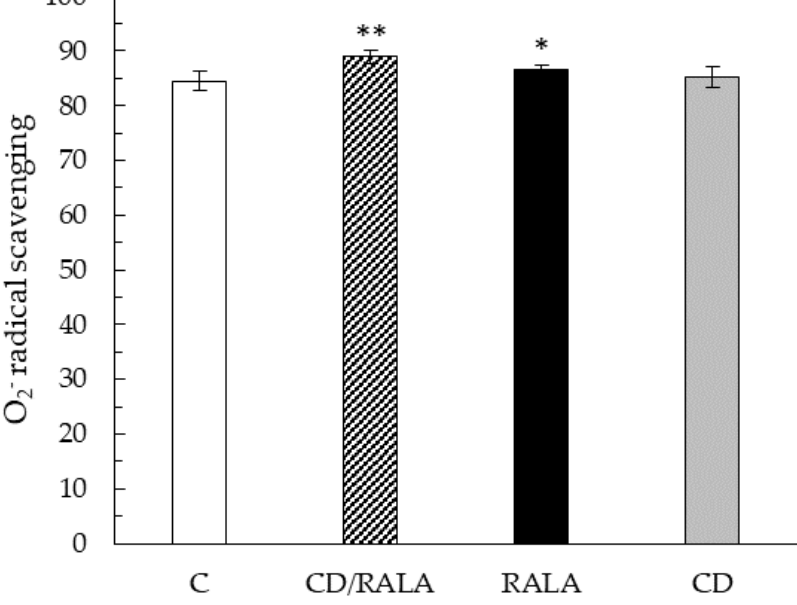
Figure 5. O 2 − radical scavenging activity (%) of the kidney. Values are expressed as the mean ± SD for six mice in each group. C, control group; CD/RALA, R- α -lipoic acid γ -cyclodextrin complex group; RALA, R- α -lipoic acid group; CD, γ -cyclodextrin group. ** p < 0.01 vs. C. * p < 0.05 vs. C. Table 3. O 2 − radical scavenging activity (%) of each organ.